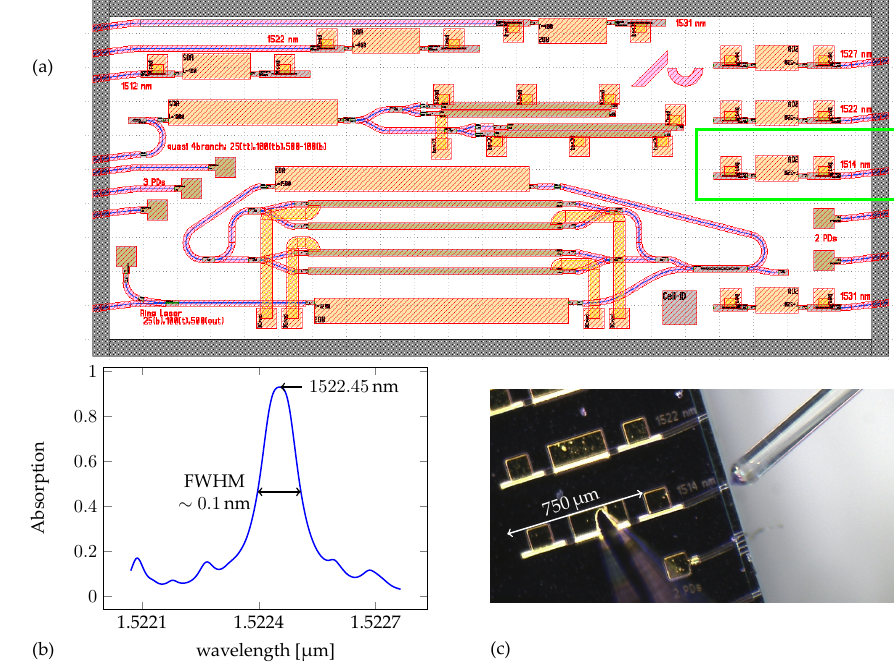
Figure 2. ( a ) Mask submitted to the foundry. The laser used in the experiment is framed in green. The chip is 2 4.6mm 2 in size. ( b ) Absorption of 5% ammonia gas mixture after 1.65 m propagation × at atmospheric pressure. ( c ) Microscope image of the laser structure as highlighted in green in ( a ). The picture shows the probe needle landed on the metal pad to inject current to the semiconductor optical amplifier (SOA) as well as the lensed fiber used for